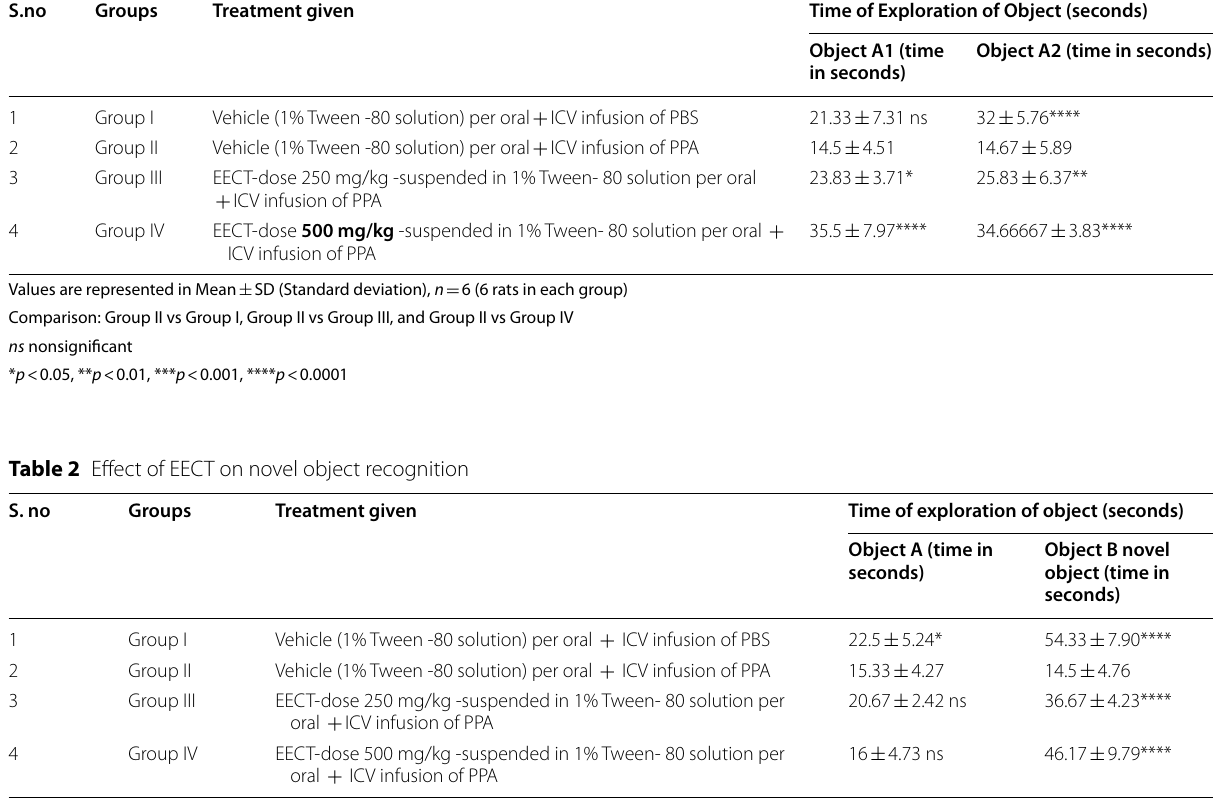
Values are represented in Mean Comparison: Group II vs Group I, Group II vs Group III, and Group II vs Group IV ns